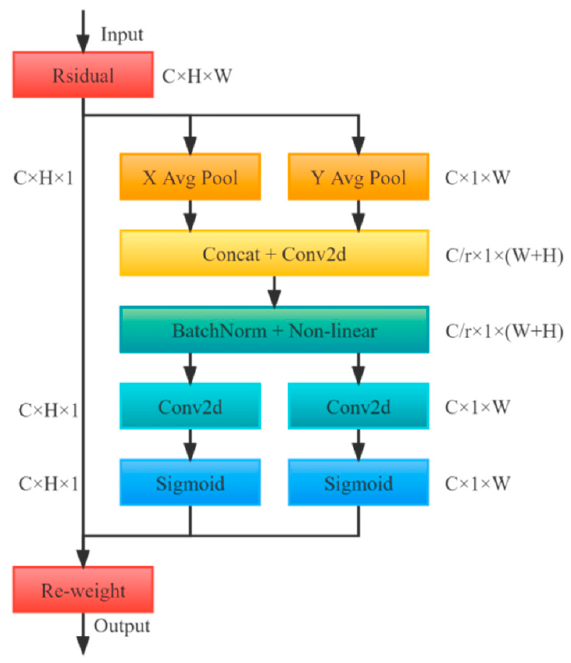
Figure 4. Coordinate Attention Module.